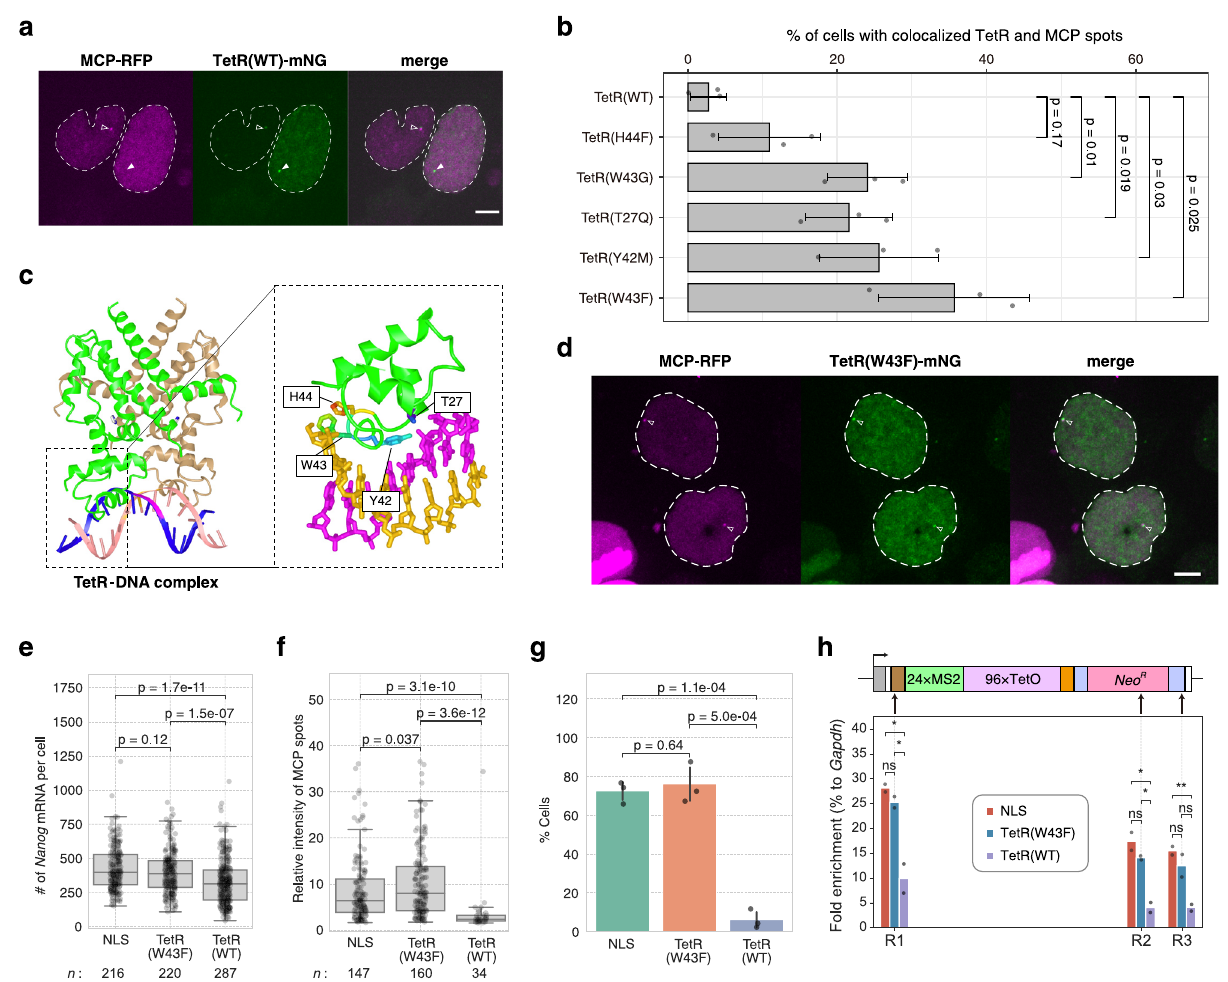
Fig. 3 | TetR(W43F) is more suitable than TetR(WT) for DNA labeling. a Nanog STREAMING-tag knock-in (NSt) cells transiently expressing TetR(WT)-mNG and MCP-RFP. In cells with high TetR(WT)-mNG expression (right), MCP spots that overlapped with TetR(WT) spots were rarely observed (closed arrowhead). In cells with low TetR(WT)-mNG expression (left), MCP spots tended to overlap with TetR(WT)spots(openarrowhead).Dashedlineindicatesthecellnucleus.Scalebar, 5 µ m. b Percentage of cells in which TetR and MCP spots were simultaneously visible and colocalized. Mean values with SD of three biological replicates (>30 cells) are shown. P -values correspond to unpaired, two-sided Student ’ s t -test. c 3D structure of TetR (PDB 1QPI) and mutation site location. d Images of NSt cells co- transfected with TetR(W43F)-mNG and MCP-RFP. Open arrowheads indicate TetR(W43F)spotswithMCPspots.Dashedlineindicatesthecellnucleus.Scalebar, 5 µ m. e Distribution of Nanog mRNA counts in NSt derived cell lines expressing MCP-RFP and either NLS-mNG (NLS), TetR(W43F)-mNG (TetR(W43F)), or